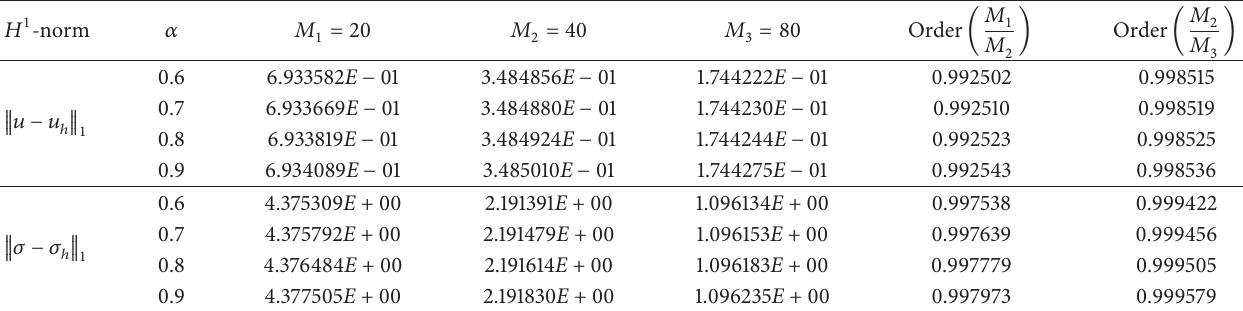
Table 4: Space-time convergence results in 𝐻 1 -norm with ℎ = 5Δ𝑡 = 1/𝑀 and changed 𝛼